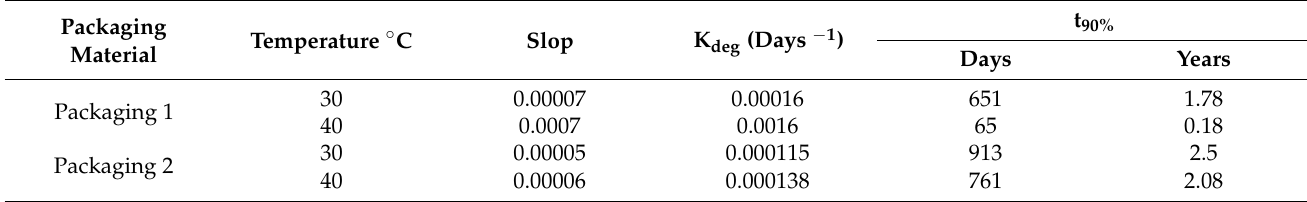
Table 5. The shelf life of the samples stored in packaging 1 and packaging 2.